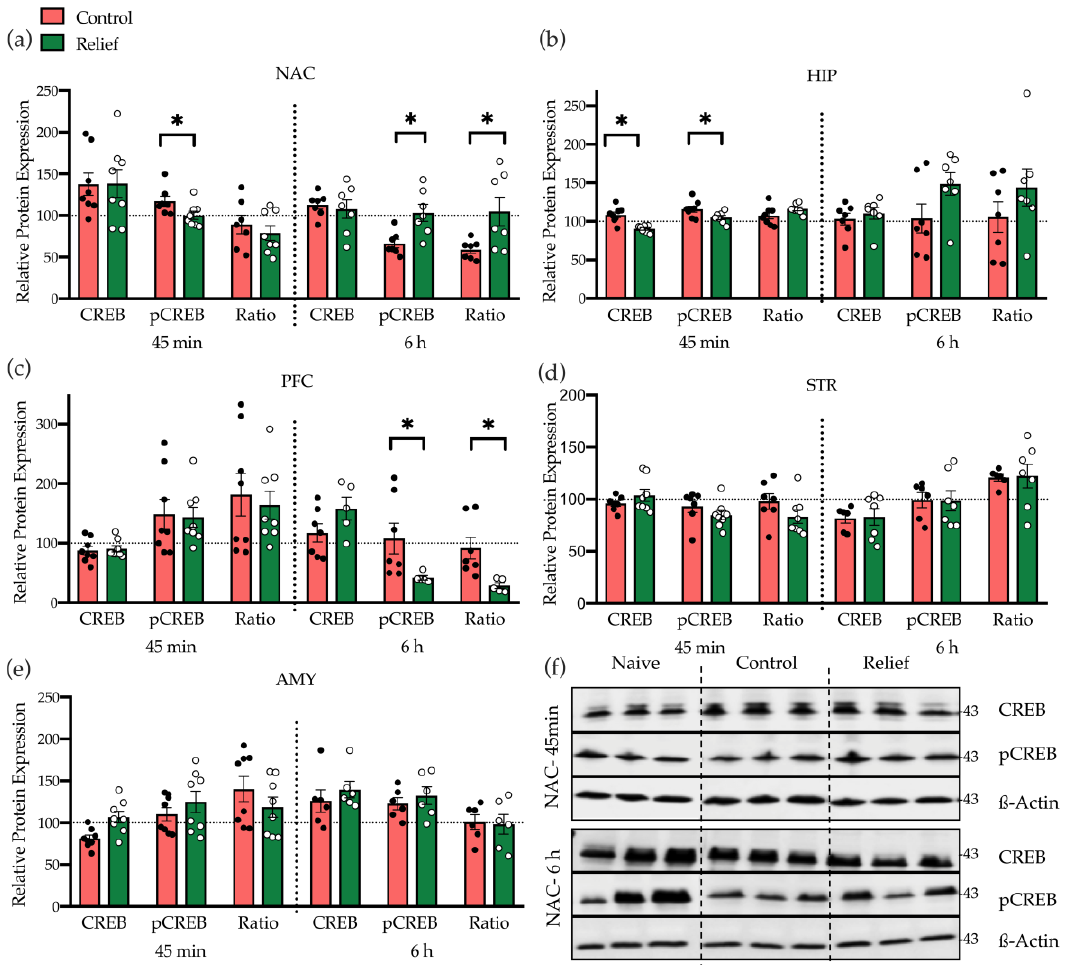
Figure 3. Expression and phosphorylation levels of CREB 45 min and 6 h after control and relief conditioning. ( a ) In the nucleus accumbens (NAC), the phosphorylation level of CREB was lower after 45 min but higher after 6 h in relief conditioned rats than in control-conditioned rats. ( b ) In the HIP, CREB, and pCREB expression were lower 45 min after relief conditioning, compared with control conditioning. ( c ) In the PFC, a significant decrease of pCREB and the phosphorylation ratio were observed 6 h after relief conditioning. ( d ) In STR and, ( e ) the AMY no differences between the two conditioned groups were seen. ( f ) A representative example of a Western blot representing the total and the phosphorylation levels of CREB in the NAC, 45 min and 6 h after conditioning, showing higher level of pCREB in relief conditioning compared with control conditioning (3 different biological samples/group). Bar diagrams depict the mean ± SEM ( n = 7–8/group; * p ≤ 0.05).